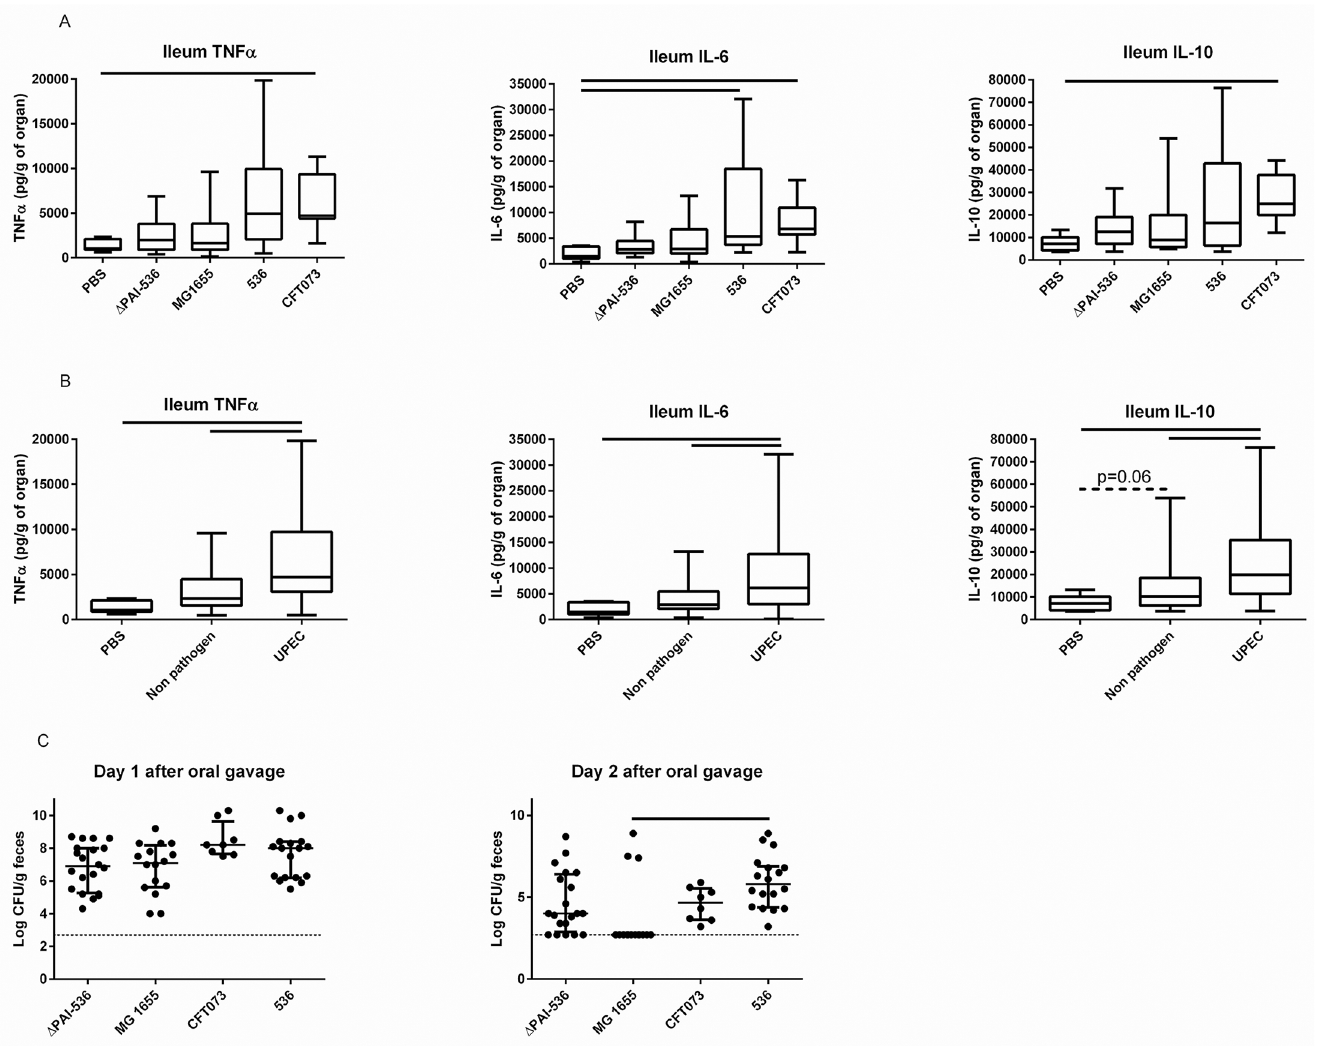
Fig 4. A: TNF α , IL-6, and IL-10 cytokine ELISA measurements in the ileum 2 days after oral gavage with 100 μ L of PBS (controls), or 10 7 CFU of Δ PAI-536, MG1655, CFT073 or E . coli strain 536. Box and whiskers represent medians and interquartile ranges. Lines indicate significant differences (p < 0.05 by Kruskal-Wallis test with Dunn ’ s correction for multiple comparisons). B: the same measurements are represented in 3 groups: PBS (controls), non- pathogenic or attenuated strains (pooled data from Δ PAI-536 and MG1655) and UPEC strains (pooled data from CFT073 and E . coli strain 536). Box and whiskers represent medians and interquartile ranges. Lines indicate significant differences (Mann-Whitney U tests). C: E . coli fecal concentration one and two days (time of the sacrifice for cytokine measurement) after oral gavage. Bars and whiskers represent medians and interquartile ranges. Mice who cleared E . coli were assigned a bacterial load of 500 CFU g/feces, i.e. 2.7 log 10 (CFU/g of feces), which was the limit of detection in our model. The line indicates a significant difference (Kruskal-Wallis tests with Dunn ’ s correction for multiple comparisons). Enterobacteriaceae-free C3H/HeOuJ mice only were used for this experiment. E . coli CFUs were enumerated in the feces by serial dilution on MacConkey agar plates and expressed as log 10 (CFU/g feces). Each dot represents one E . coli fecal